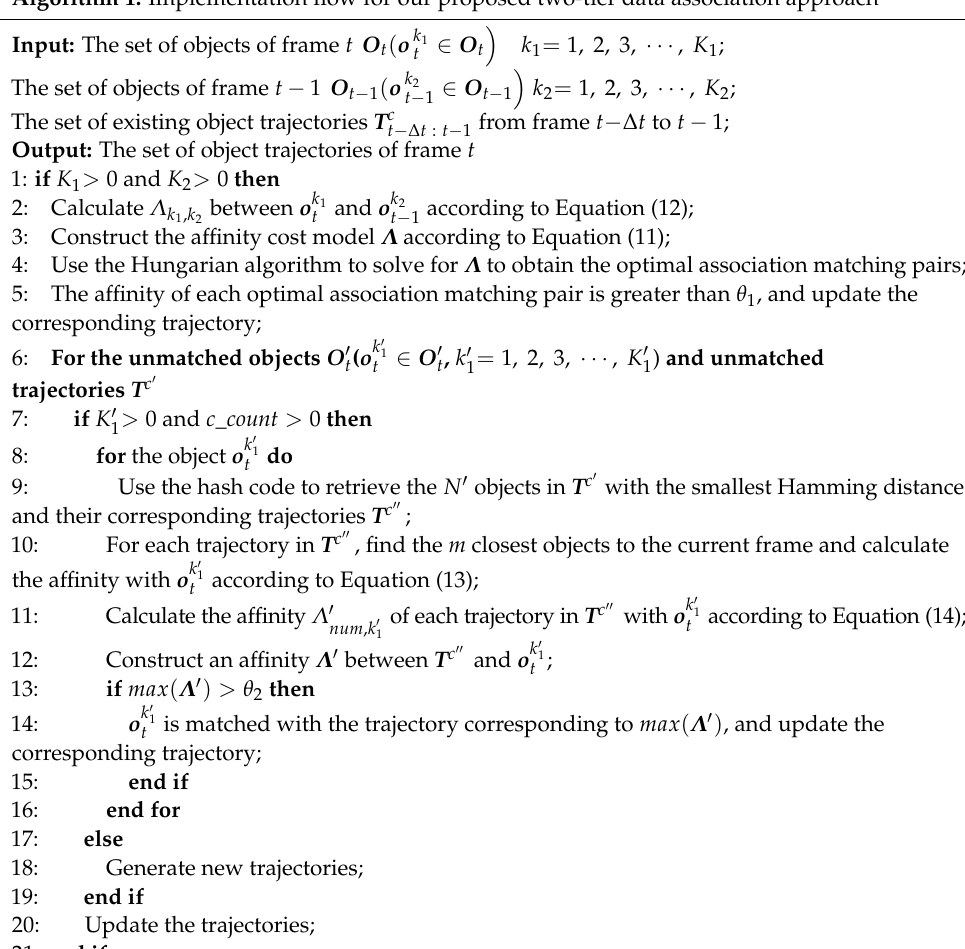
Algorithm 1: Implementation flow for our proposed two-tier data association